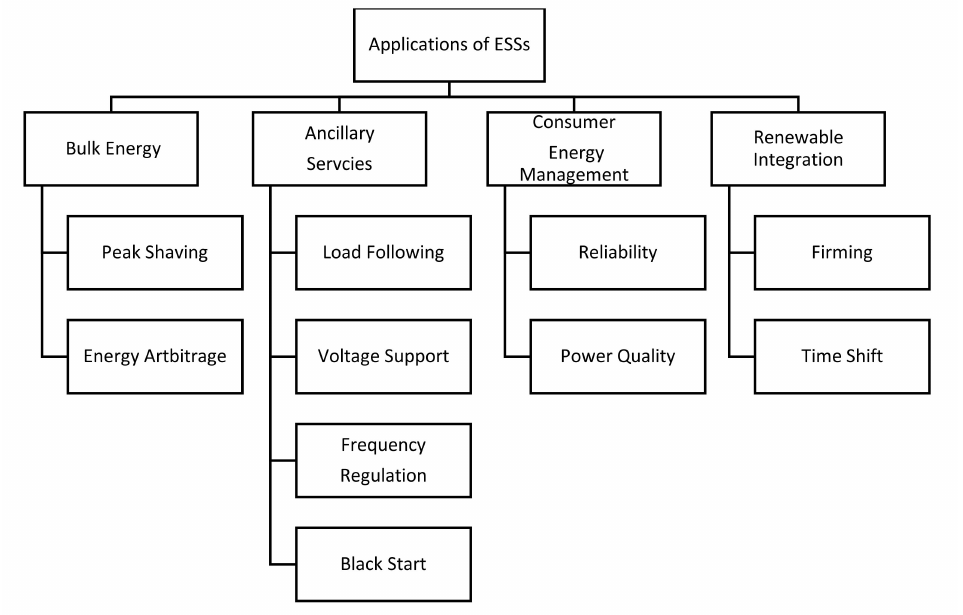
Figure 3. Multifaced applications of energy storage systems in smart grids [176,219]. Table 7. Technical characteristics of energy storage technologies